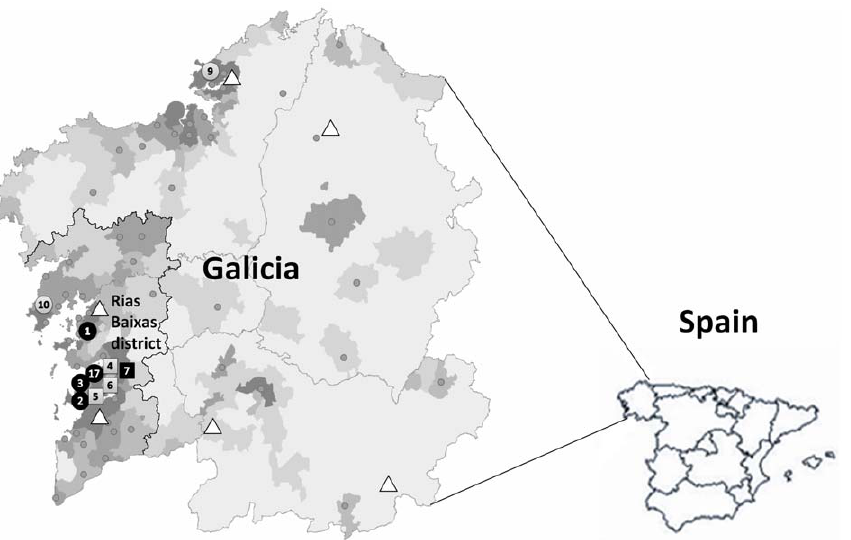
Figure 1. Population density map (in contemporary Galicia) showing the geographic distribution of the Galician ARCI families. Grey dots: built-up areas with 10000 or more inhabitants. Black circles: homozygous c.2278C . T carriers. Black squares: homozygous c.1223_1227de- lACACA carrier. Grey squares: c.2278C . T/c.1223_1227delACACA carriers. Grey circles: ARCI patients carriers of c.984 + 1G . A. Triangles: ARCI families harboring other mutations.